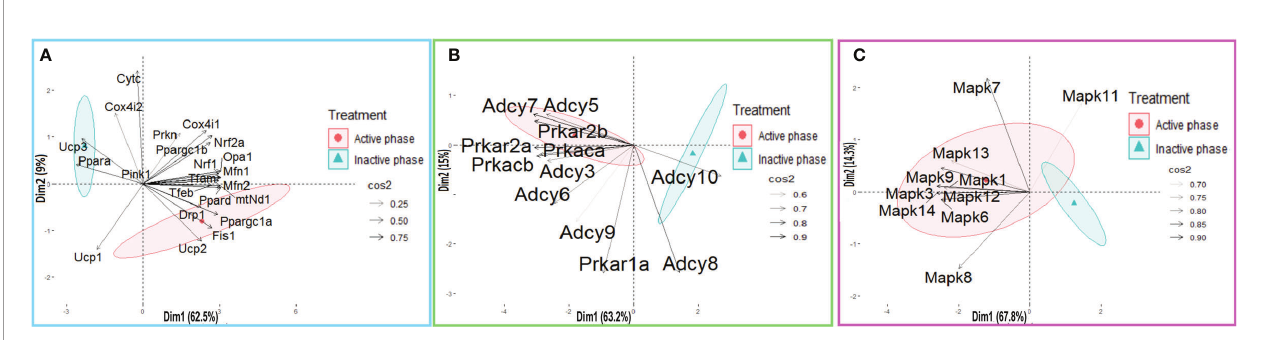
FIGURE 12 | PCA of mitochondrial dynamics (A) , cAMP signaling pathway (B) , and MAPK signaling pathway (C) gene expression on active/inactive phase; Dim1 and Dim2 represent the fi rst two PCs and % of the retained variation. Cos2 estimates the qualitative representation of variables ( Supplementary Tables S1 – S3